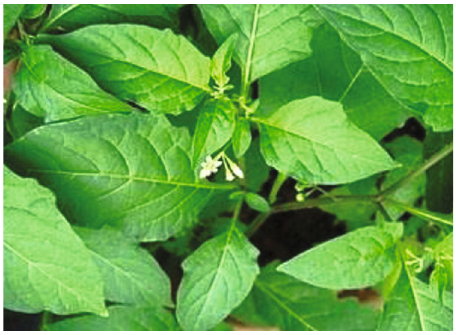
Figure 5: Solanum nigrum L.